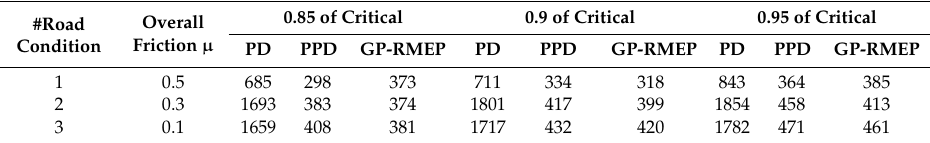
Table 5. Steering controllers target quality function for each parameter combination.